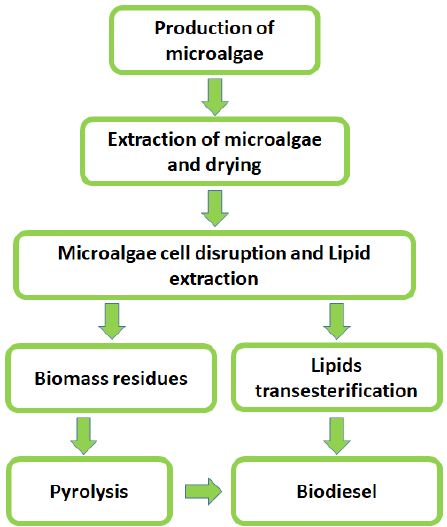
Figure 5. Pathways of processing microalgal lipids into biodiesel. Modified according to [93]. Reprinted with permission from ref. [93]. 2021 © Portal hrvatskih znanstvenih i stru č nih č asopisa— Hr č ak.